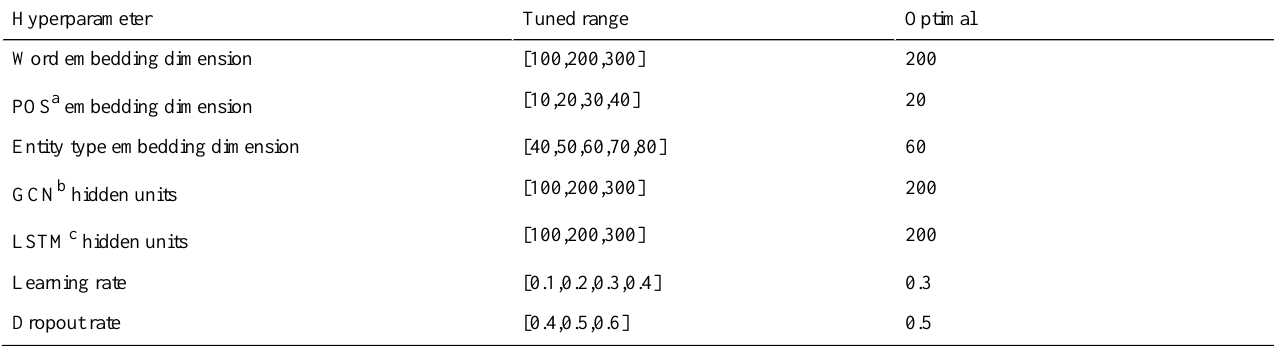
Table 3. Hyperparameter